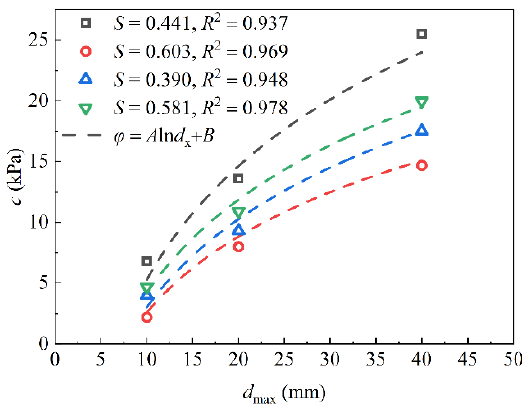
10 of 18 Figure 6. Relationship of shear stress and strain. ( a ) S = 0.581, d max = 40. ( b ) S = 0.581, d max = 20. ( c ) S = 0.581, d max = 10. Figure 7. Relationship between internal axial pressure and shear strength of test CGS. According to the test results of D1-4 to D4-4, the maximum particle size d max and shear strength indexes are sorted out by cohesion ϲ and internal friction angle φ . The variation relationship is shown as the discrete points in Figures 8 and 9. As can be observed, the maximum particle size has a great impact on the shear strength characteristics of CGS. Furthermore, regardless of the gradation structure, both cohesion ϲ and internal friction angle φ increase with the improvement of the maximum particle size d max . The triaxial shear test results of rockfill materials for ϲ and φ carried out by Li et al. [11] are consistent